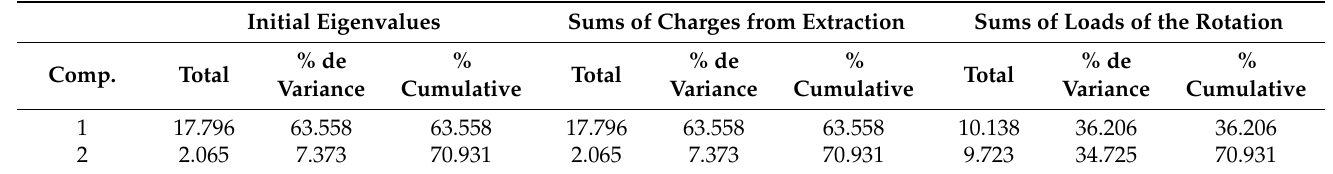
Table 15. Factor Extraction of Ethical Values on